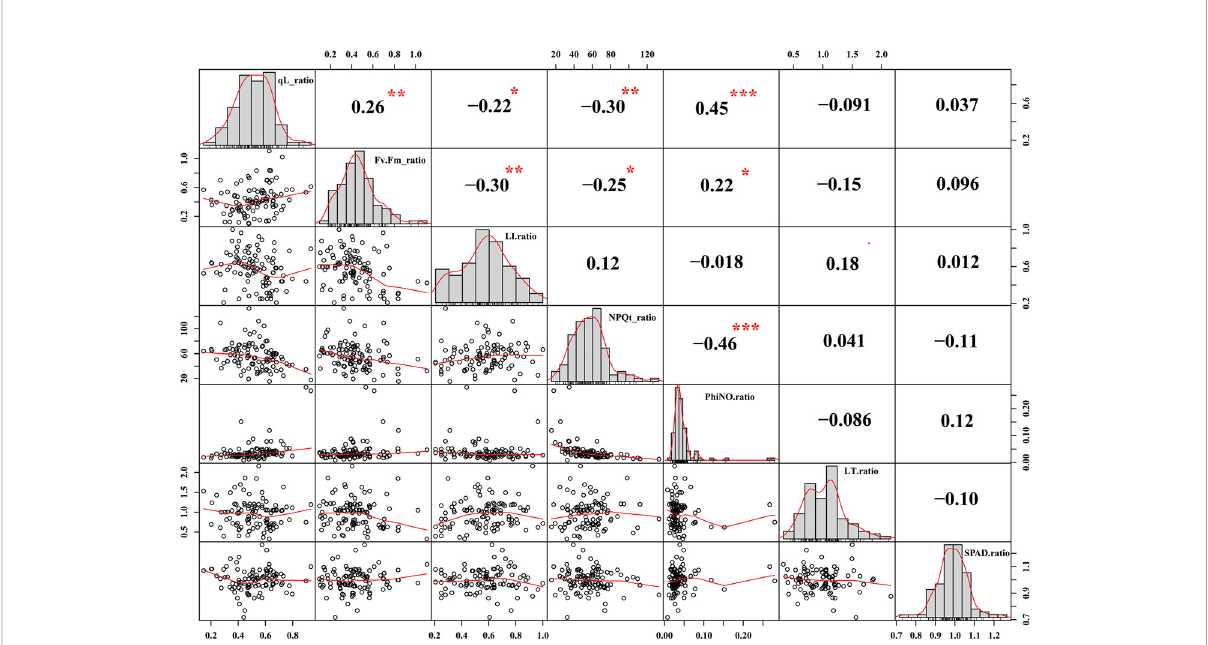
FIGURE 3 Correlation analysis of different evaluated traits in Soybean. Traits for correlation analysis: qL ratio = qL_Cold/qL_CK, Fv/Fm ratio = Fv/Fm_Cold/ Fv/Fm _CK, Leaf injury ration (LI) ratio = LI_Cold/LI _CK, Non-photochemical quenching (NPQt) ratio = NPQt_Cold/NPQt_CK, phiNO ratio = phiNO_Cold/phiNO _CK, Leaf thickness (LT) ratio= LT_Cold/LT_CK, and SPAD ratio= SPAD _Cold/SPAD _CK. The ***, ** and * asterisks indicate the signi fi cant correlation at p-value <0.001, <0.01 and p-value <0.05,